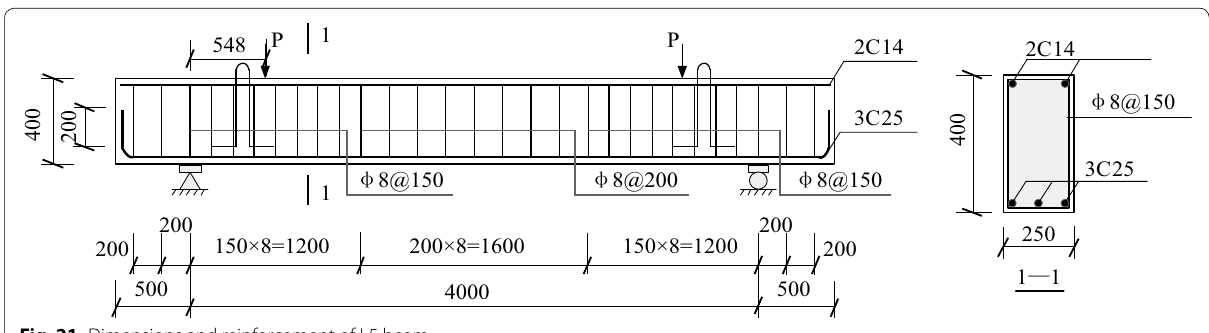
Fig. 21 Dimensions and reinforcement of L5